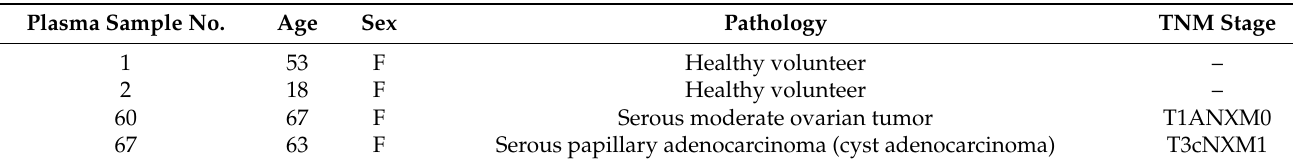
Table 1. Clinical and morphological characteristics of the plasma